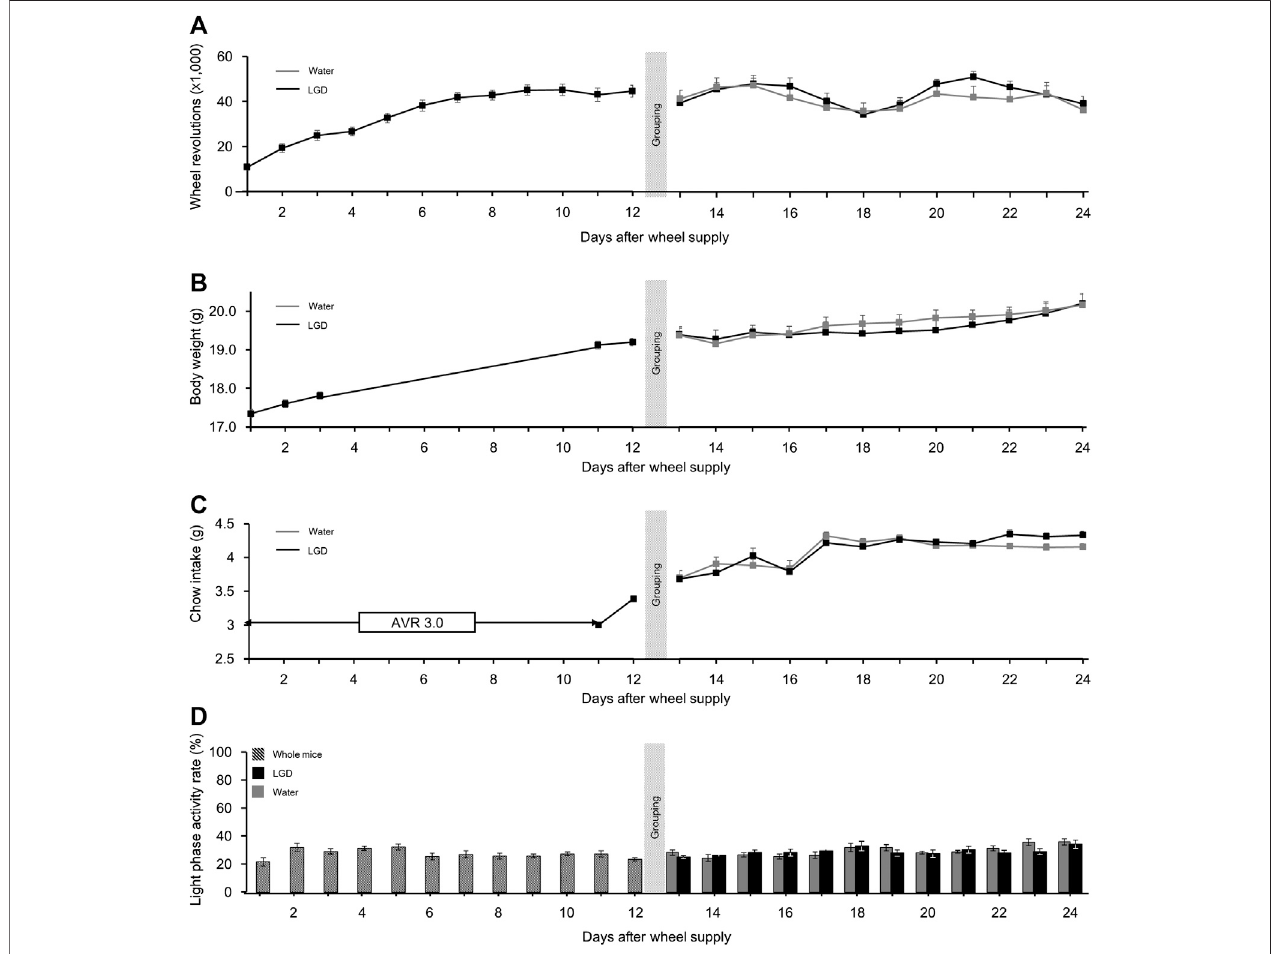
FIGURE 5 | Effect of licorice and dried ginger decoction (LGD) on voluntary running mice. (A) Comparison of wheel revolutions. (B) Comparison of body weight change. (C) Comparison of food intake. (D) Comparison of the light phase activity. All results are expressed as mean ± SEM.